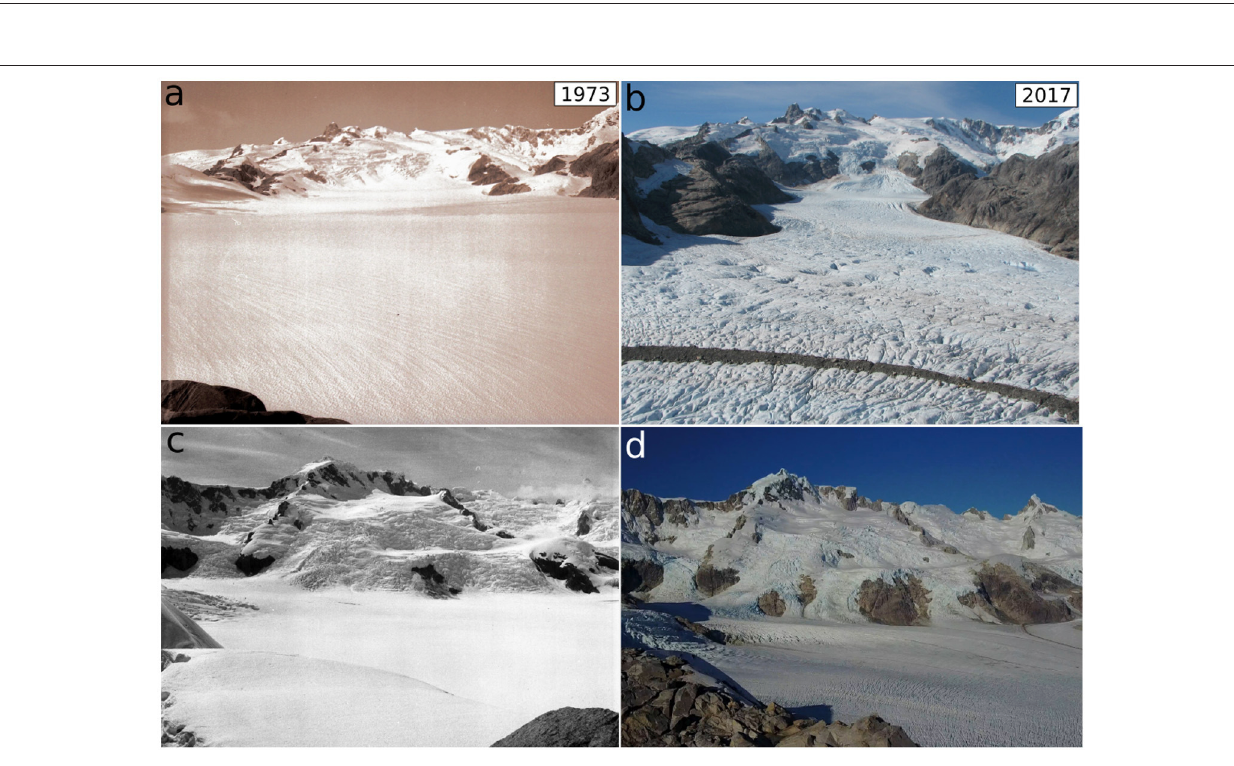
FIGURE 2 | (a) Cross-sectional surface elevation across Profile x between 1973 and 2017. Dashed lines indicate uncertainty. (b) Same as (a) but for the longitudinal Profile y. The points used to construct the 1973 longitudinal profile are shown in Figure 1B . (c) Magnitude of surface lowering based on Profile x and y. The profiles are located in Figure 1B .